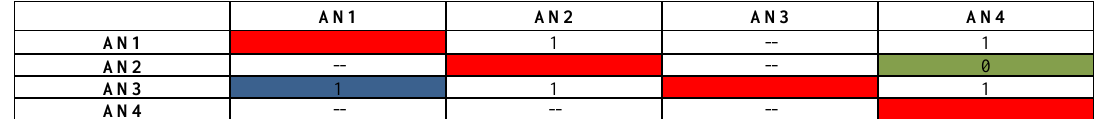
Table 22. Dominating interaction matrix of actions for performance